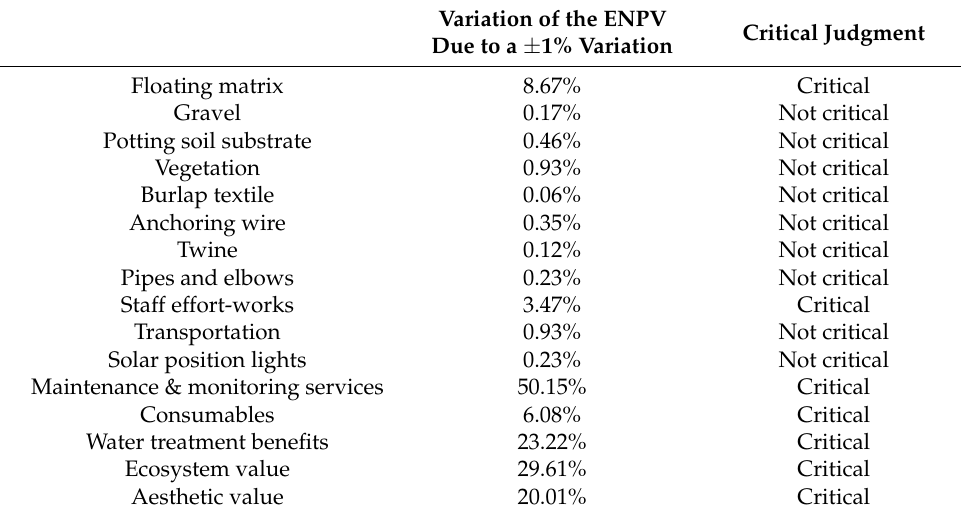
Table 9. Sensitivity analysis of economic performance